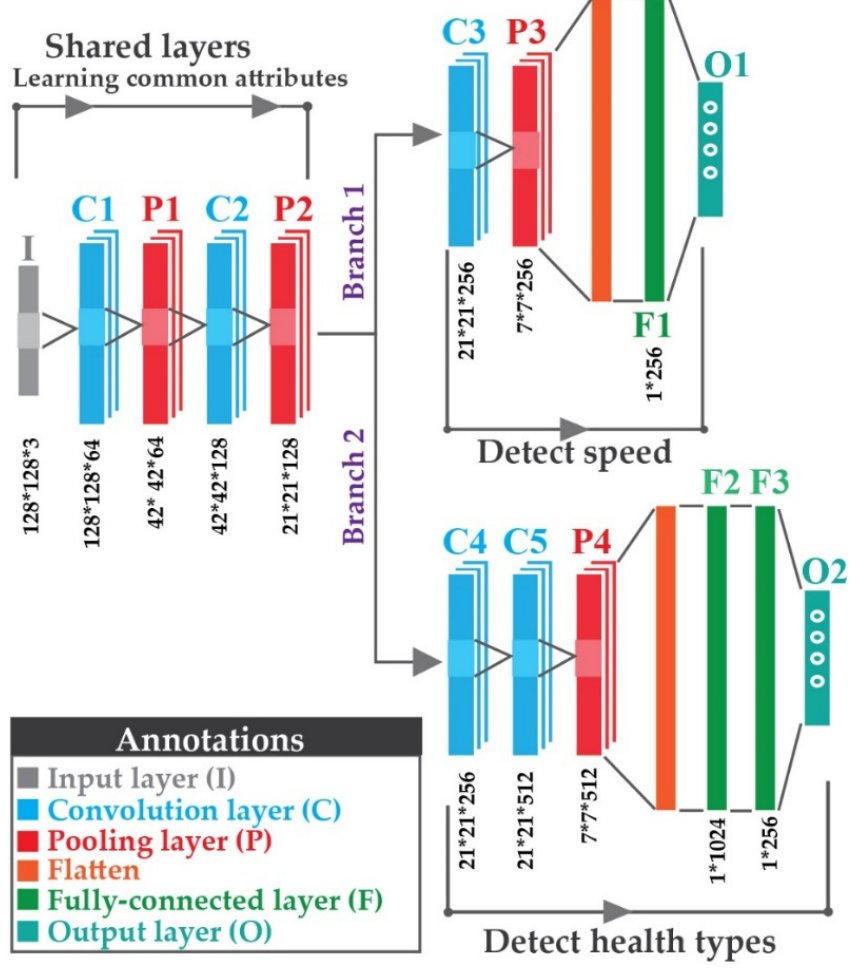
Figure 5. Proposed framework for CNN-based multi-task net (MTL-CNN).